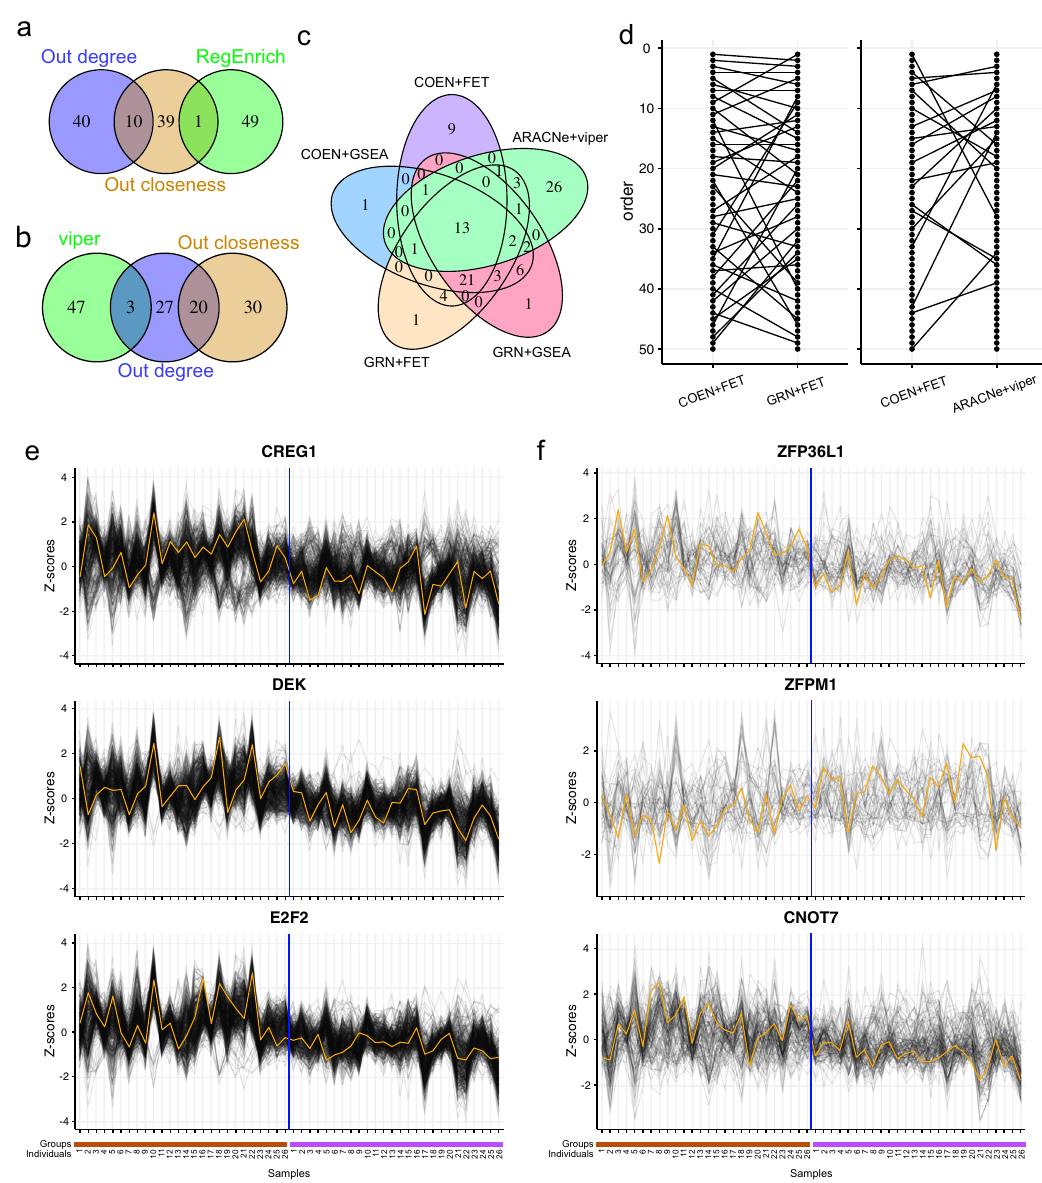
Fig. 3 Comparison of key regulators (or hubs) identi fi ed by different methods. Venn diagram shows the overlap between the top 50 hubs/regulators (a) de fi ned by out-degree, out-closeness and the RegEnrich score (using COEN network and FET enrichment method), (b) de fi ned by out-degree, out- closeness and the VIPER package (using ARACNe network). (c) Venn diagram shows the overlap between the top 50 hubs/regulators de fi ned by RegEnrich (using different parameter combinations) and those by the VIPER package. (d) Ladder plots compare the rank of regulators identi fi ed by RegEnrich using different network inferencing methods, and those by RegEnrich and by VIPER. Lines connect the same regulators. The expression pattern of top three key regulators and their targets identi fi ed by (e) RegEnrich using COEN network and FET method and by (f) VIPER. Orange lines are the normalized expression of regulators and grey lines are the normalized expression of the targets of the regulators. The brown bars below the x-axis indicate samples at week 1, and purple bars the samples at week 3. The analyses were performed using the data obtained from 34